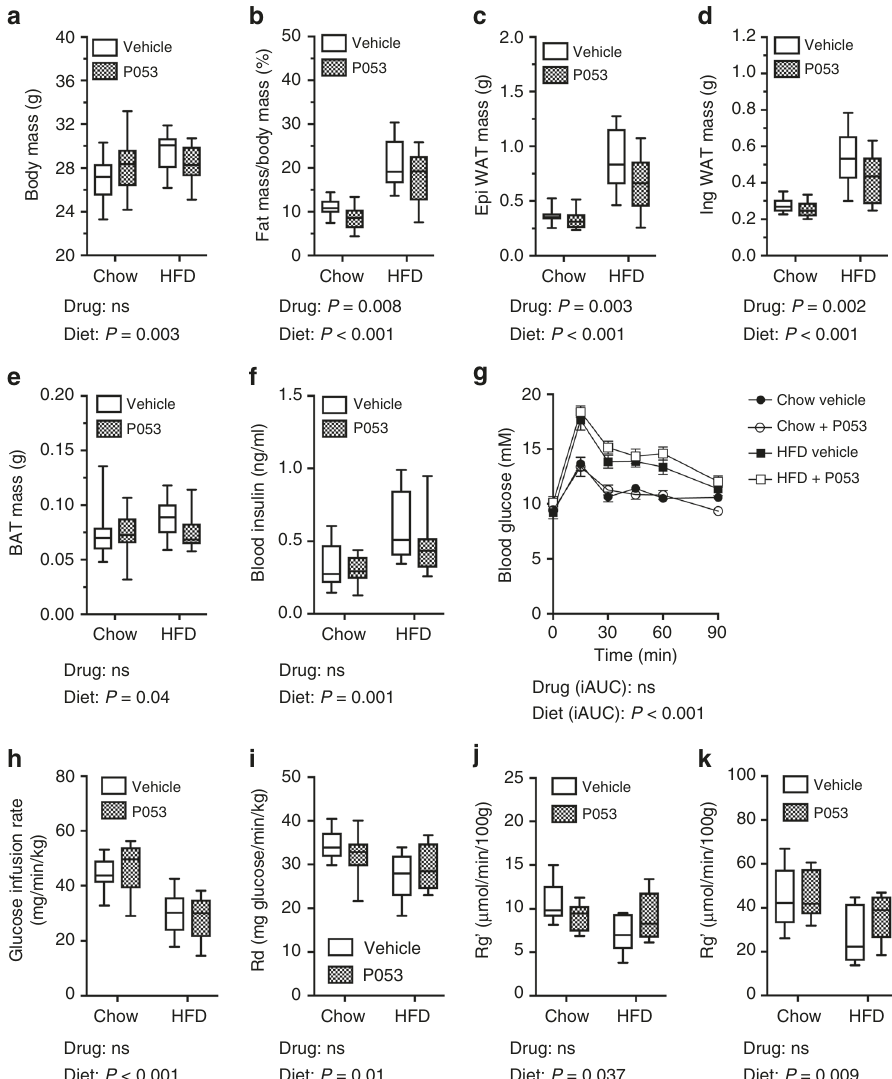
Fig. 4 CerS1 inhibition impedes fat accumulation but not insulin resistance in mice fed a HFD. a Total body mass, b fat mass as a % of body mass determined by EchoMRI, c epididymal white adipose tissue (WAT) mass, d inguinal WAT mass, and e brown adipose tissue (BAT) mass, in mice fed chow or HFD with vehicle or 5 mg/kg P053 for 4 – 6 weeks ( n = 20 per group). f Fasting blood insulin and g blood glucose following an oral glucose load in mice fed chow or HFD with vehicle or 5 mg/kg P053 ( n = 10 per group; mean ± SEM). h Glucose infusion rate, i rate of glucose disposal from the circulation (Rd), and j , k rate of glucose uptake (Rg ’ ) into quadriceps ( j ) and soleus ( k ) muscles, as determined in hyperinsulinemic-euglycemic clamps ( n = 6 – 9 mice per group as detailed in the methods). Box and whisker plots ( a – f ) show full data range with 25th — 75th percentile boxed, and horizontal bar marking the median. P-values showing the main effect of diet or drug, as determined by two-way ANOVA, are shown below each graph; ns not signi fi cant. ANOVA results for the incremental Area Under the Curve (iAUC) are given for ( g